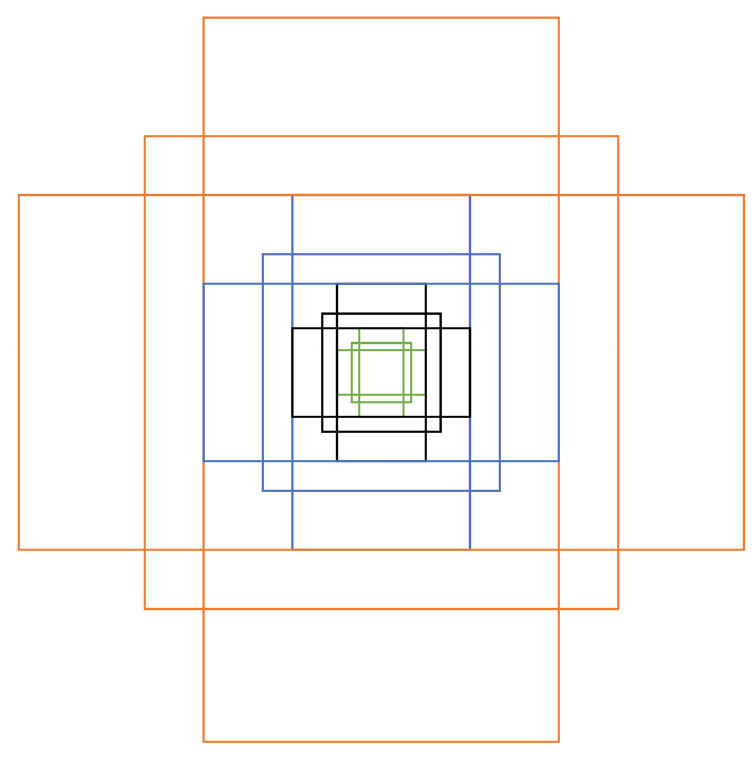
Figure 7. Enhanced anchor box after the addition of a 64 × 64 scale (green box).